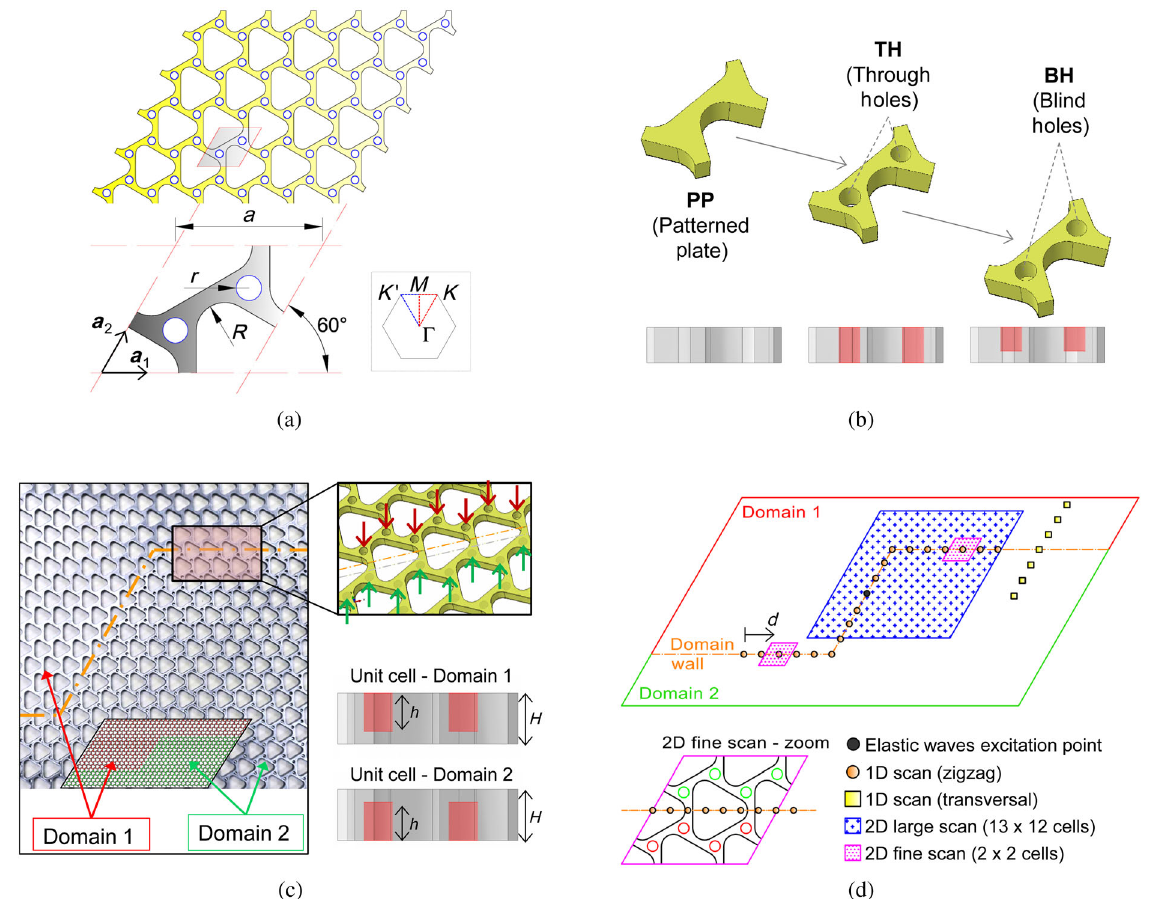
FIG. 1. Patterned plate with a topologically protected interface supporting helical edge modes and the experimental configurations. (a) In-plane view of the patterned plate and schematic representation of the unit cell. The inset shows the Γ , K , K 0 , and M high-symmetry points of the first irreducible Brillouin zone along which the dispersion curves presented in Figs. 2(a), 2(c), and 2(e) are calculated. (b) Perspective and cross-sectional view of the unit cells used to selectively control dispersion branches: patterned plate (PP), plate with additional circular holes drilled through the thickness (TH) and with blind holes (BH). (c) Photograph of the specimen with a Z -shaped interface (orange dashed line) separating two domains with blind holes drilled on the opposite (top or bottom) surfaces of the plate. The inset shows the arrangement of the reversed unit cells on the full specimen ( 20 × 33 unit cells) highlighted by the red (domain 1) and green (domain 2) arrows. The top and bottom parts of the right panel show a zoom of the domain wall and the cross sections of the domain-1 and domain-2 unit cells with the reversed holes, respectively. (d) Summary of the experimental scans conducted on the plate for the investigation of its topological waveguiding characteristics. Elastic waves are excited by means of a piezoelectric transducer bonded at the location marked by the circular black dot. The picture illustrates SLDV 1D scans following the Z -shaped interface (orange circular dots) and transverse to the domain wall (yellow square dots), as well as 2D scans on 13 × 12 unit cell (blue) and 2 × 2 unit cell (magenta) areas. The letter d indicates the curvilinear coordinate running along the